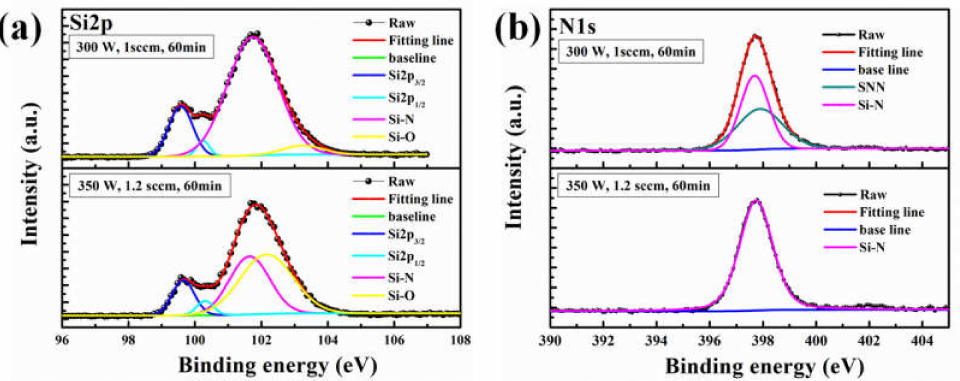
Figure 3. ( a ) Si 2 p spectra and ( b ) N 1 s spectra of binding energy of nitrided Si x N y grown on Si(111) surface for 60 min with RF: 300 W, N 2 : ~1 sccm, and RF: 350 W, N 2 : ~1.2